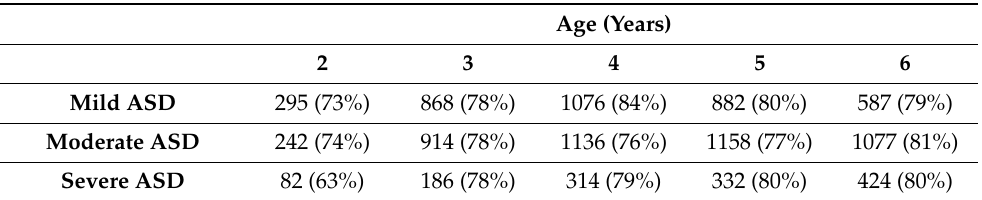
Table 1. The number of participants in each age group and ASD level. The number in brackets shows the percentage of